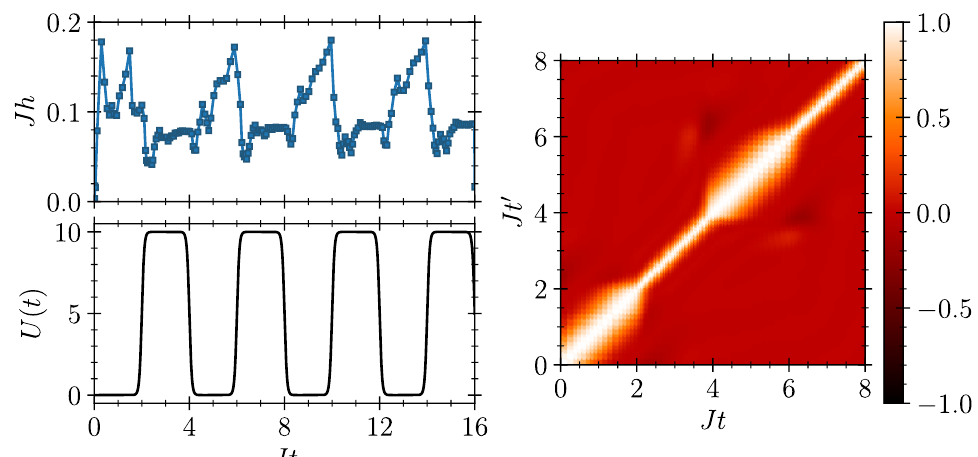
( t , t (cid:48) ) (right) for the same 11, ↑